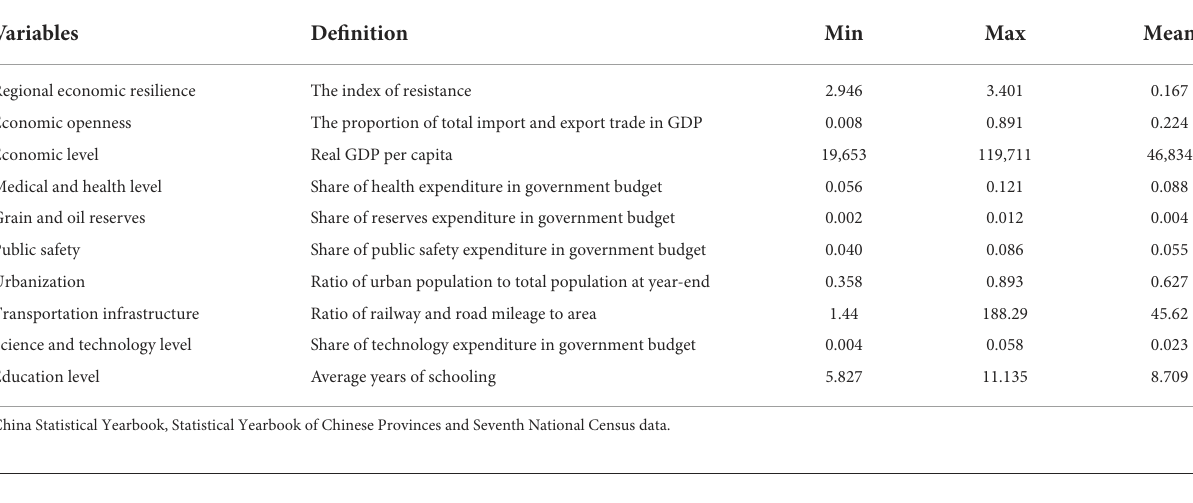
TABLE 1 Variables and descriptive analysis.